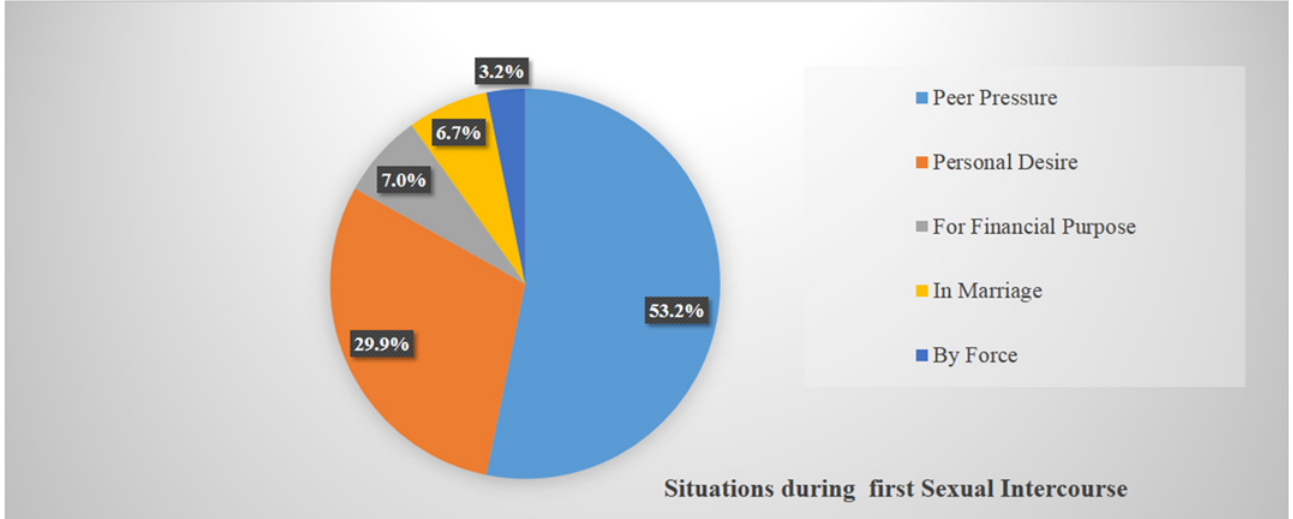
Fig 1. Situations how first sexual intercourse was started among young people in Northwest Ethiopia, 2015 (n = 474).